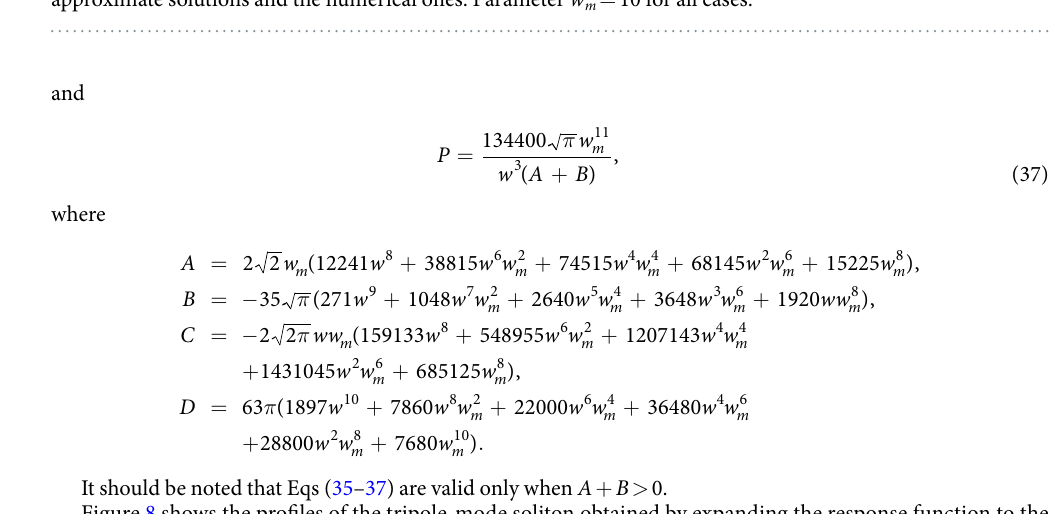
Figure 8. Profiles of the tripole-mode soliton with different soliton powers and propagation constants by expanding the response function to the tenth order. The solid line and the dashed line denote, respectively, the approximate solutions and the numerical ones. Parameter w m = 10 for all